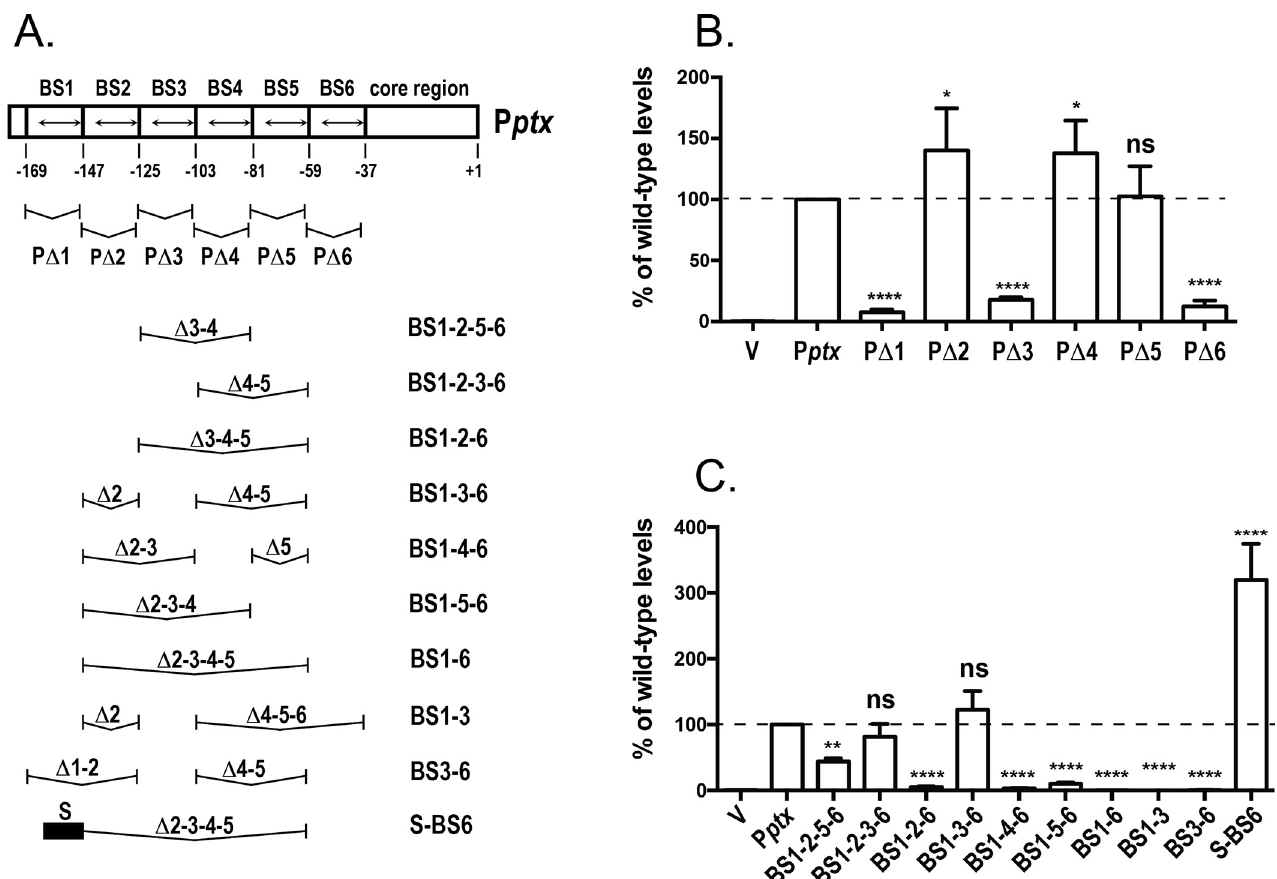
Fig 5. Contribution of P ptx BvgA-binding sites to P ptx function. A. Diagram of BvgA-binding sites within P ptx and its derivatives. Boxes delineate the extents of 22-bp deletions removing each of the six binding sites, with the binding sites themselves within each box indicated by a double-headed arrow. Below this schematic are shown the different combinations of these 22 bp segments in different derivatives. The black bar in derivative S-BS6 indicates the presence of the primary binding site from P fha (TAAGAAATTTCCTA). B & C. Luciferase activity of B . pertussis strain BP536 carrying ectopically integrated plasmids. Values for the empty pSS3967 control (V) and for promoter- lux fusion derivatives harboring the wild type (P ptx) and the deletion derivatives shown in panel A are presented. Strains were grown on BG agar at 37˚C for 2 days and assayed as described in Materials and Methods. Values were normalized to wild-type P ptx and data from at least four assays were used in the calculation of means, standard deviations, as indicated by error bars, and statistical analysis by one-way ANOVA. Outcomes of the latter analysis are presented using the symbols: ns, P > 0.05; � , P � 0.05; �� , P � 0.01; ��� , P � 0.001; ���� , P � 0.0001.